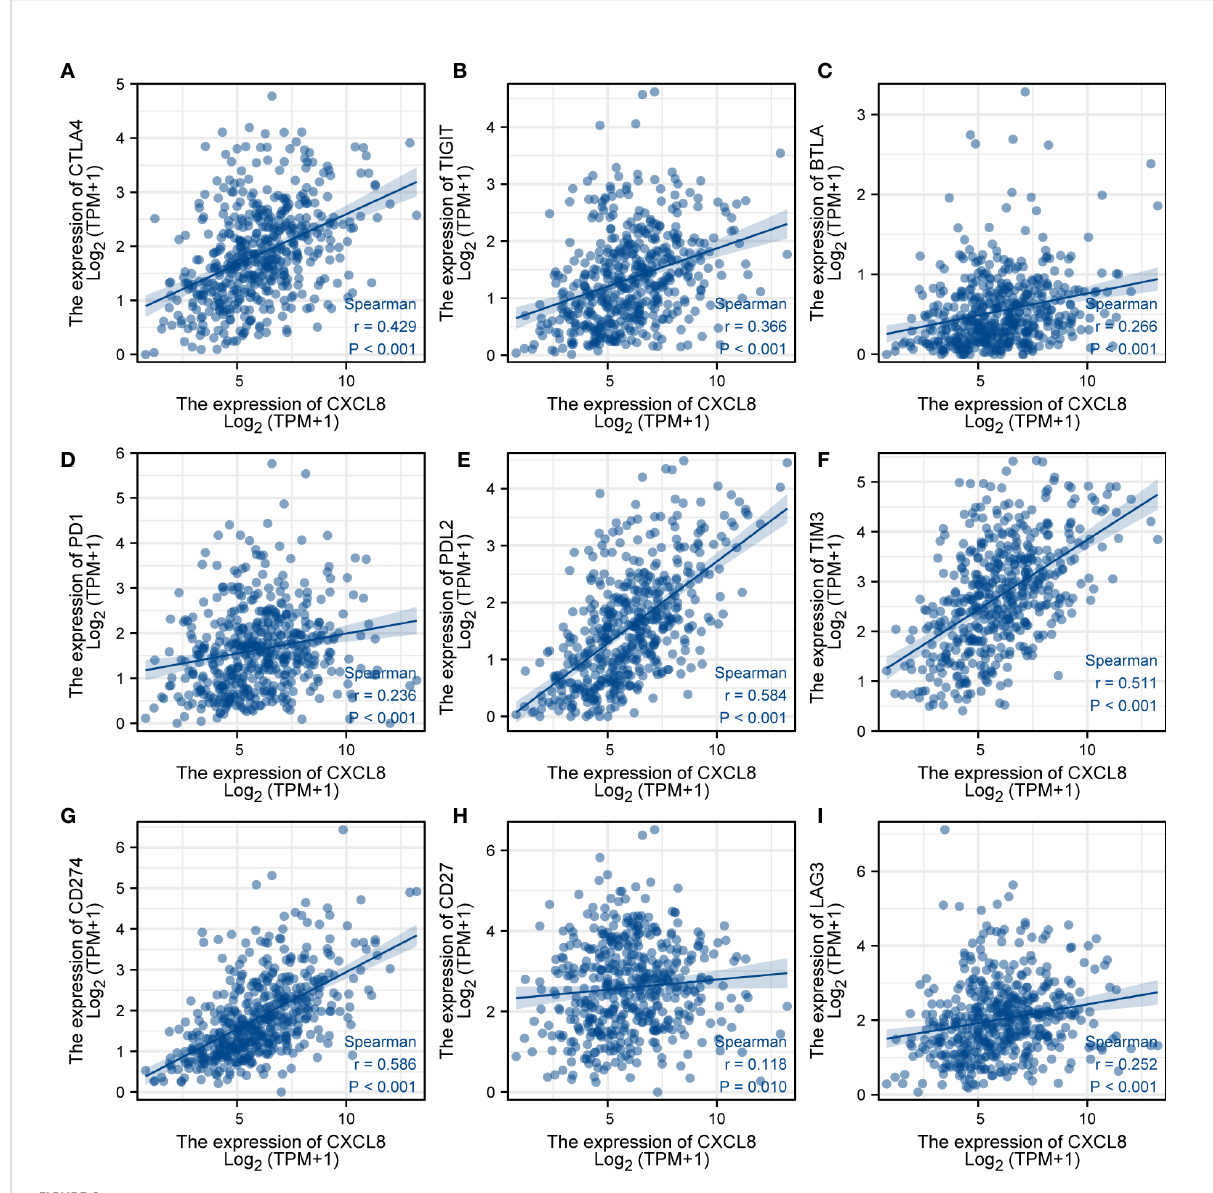
FIGURE 8 Analysis of immunotherapy responses. (A) Correlations of the expression of CXCL8 and CTLA-4. (B) Correlations of the expression of CXCL8 and TIGIT. (C) Correlations of the expression of CXCL8 and BTLA. (D) Correlations of the expression of CXCL8 and PD-1. (E) Correlations of the expression of CXCL8 and PD-L2. (F) Correlations of the expression of CXCL8 and TIM-3. (G) Correlations of the expression of CXCL8 and CD274. (H) Correlations of the expression of CXCL8 and CD27. (I) Correlations of the expression of CXCL8 and